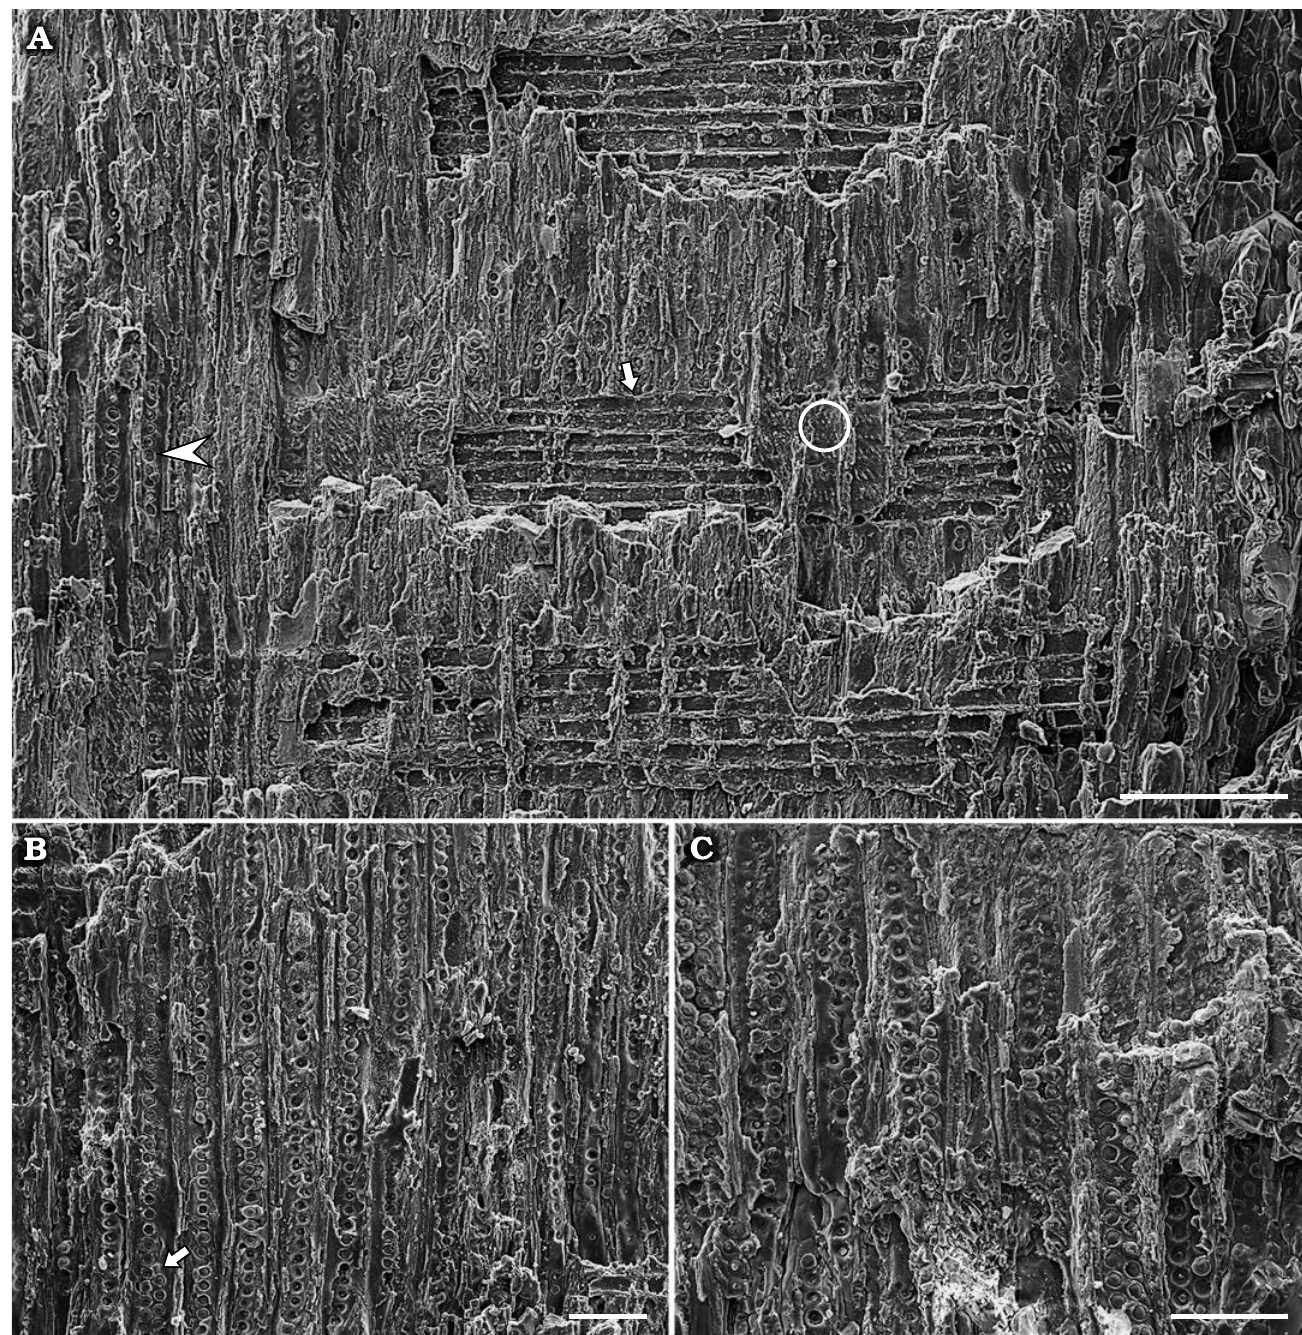
Fig. 8. Araucarian wood Agathoxylon mendezii sp. nov. (MPM­PB­15596), Estancia El Álamo, Santa Cruz Province, Argentina, Berriasian–Valanginian. Radial sections observed under SEM. A . General aspect showing ray cells (arrow), cross­fields pits (circle), axial tracheids (arrowhead). B . Detail of tra­ cheids with uniseriate, and contiguous pits, arrow shows transition from biseriate to uniseriate pit rows. C . Detail of tracheids with biseriate, contiguous, and alternate to sub­opposite pits. Scale bars: A, B, 200 µm; C, 100